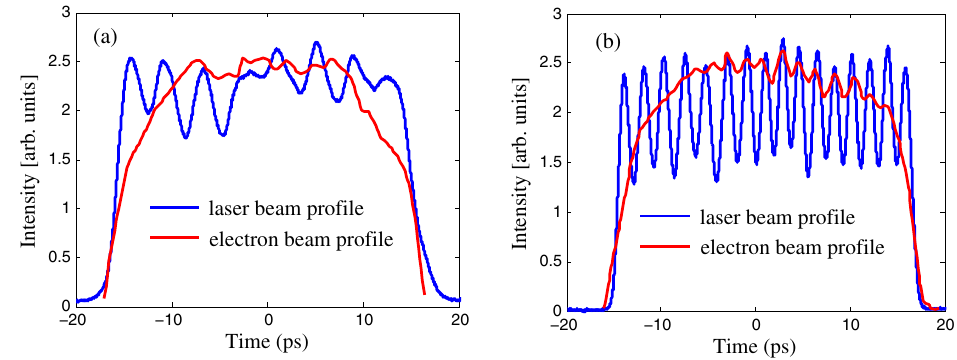
FIG. 14. (a) The laser and electron bunch profile for the 50 MHz laser and (b) for the 1.3 GHz